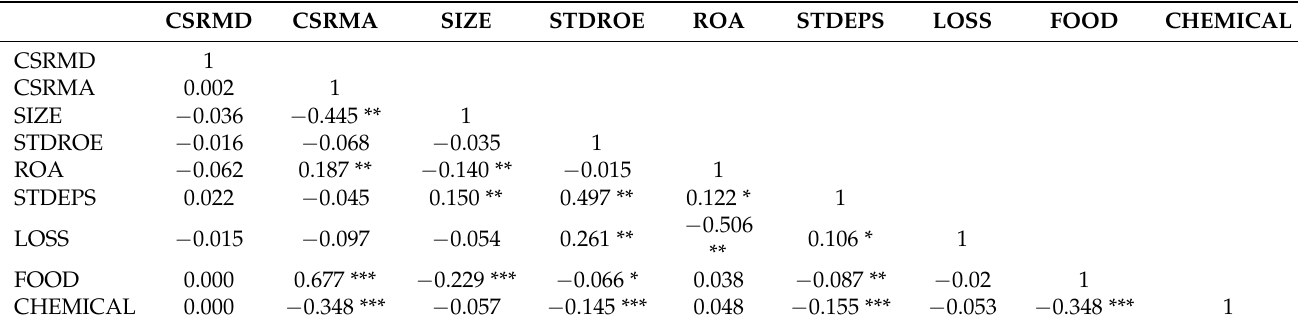
Table 3. Pearson correlation